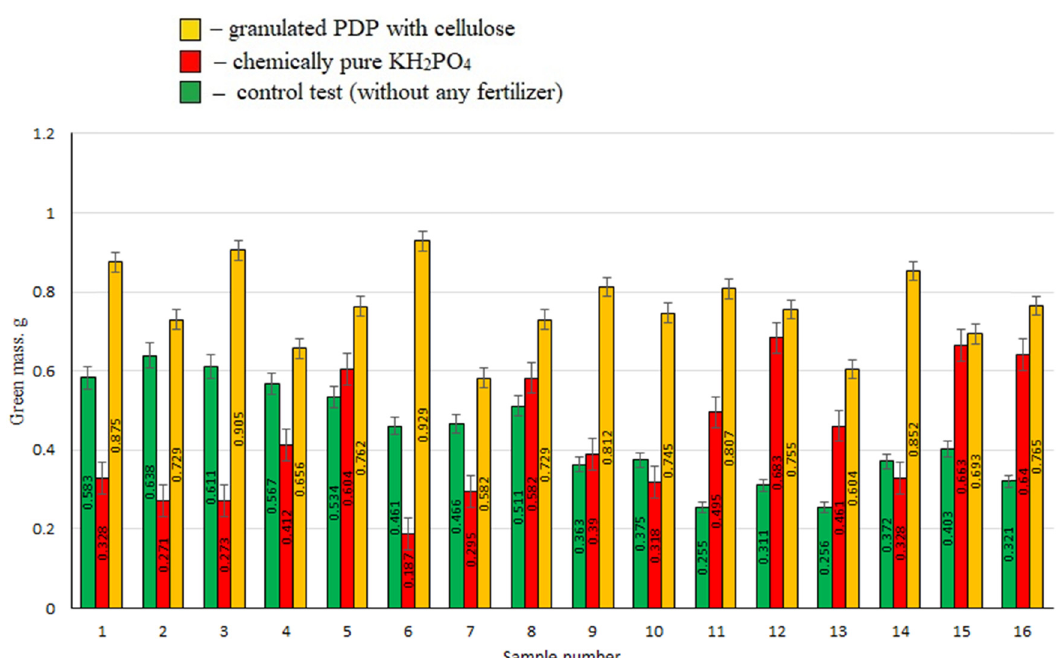
Figure 6: Leaf green mass dependence on the type of